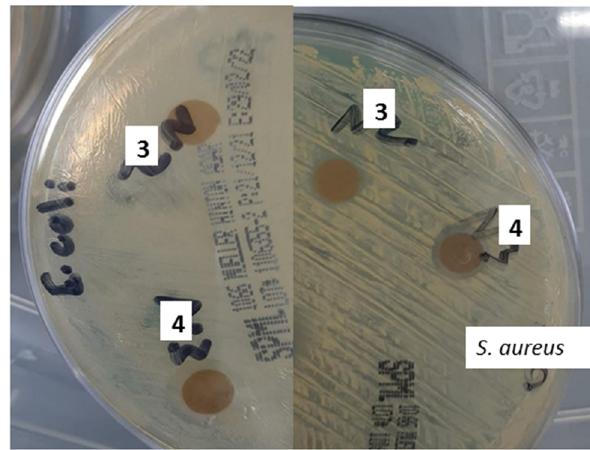
Figure 6: Antibacterial study of hydrogel fi lms ( 3 and 4 )